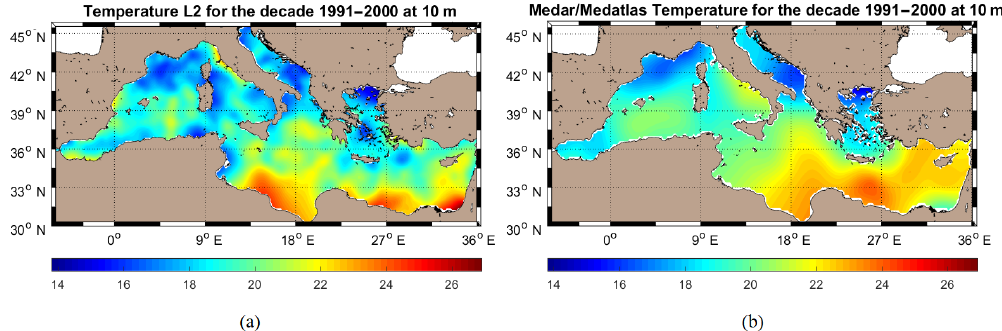
Figure 14. (a) Atlas masked temperature field for the decade 1991–2000 at 10m, (b) Medar/Medatlas temperature field for the decade 1991–2000, at 10m (no error field is